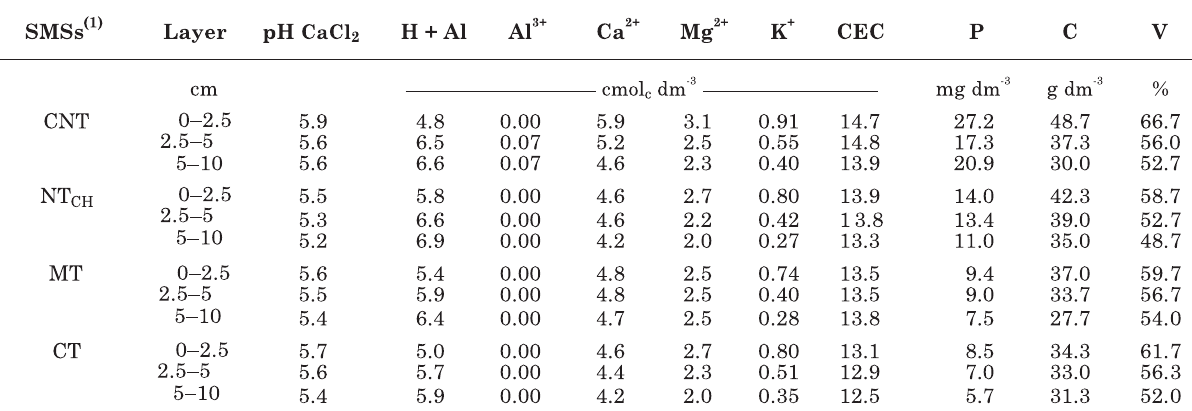
Table 1. Chemical characterization of the soil under the different soil management systems (SMSs) before the beginning of the